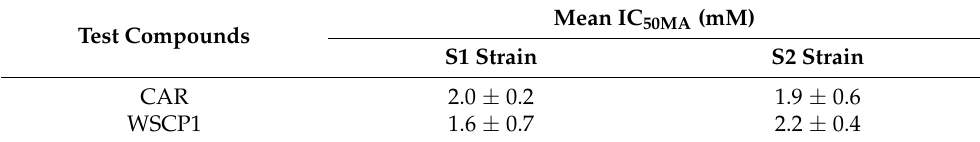
Table 3. Pma1p inhibition by the CAR and the WSCP1 in the S1 and the S2 strain of C. albicans. Test